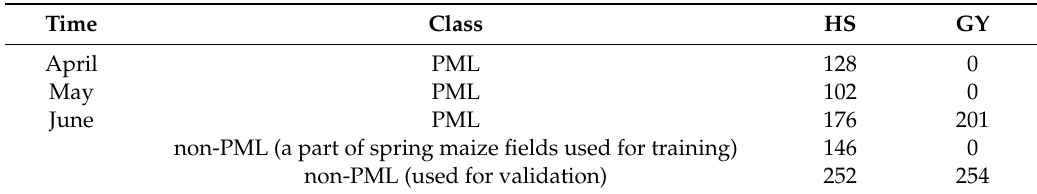
Table 2. Number of samples collected for this study.